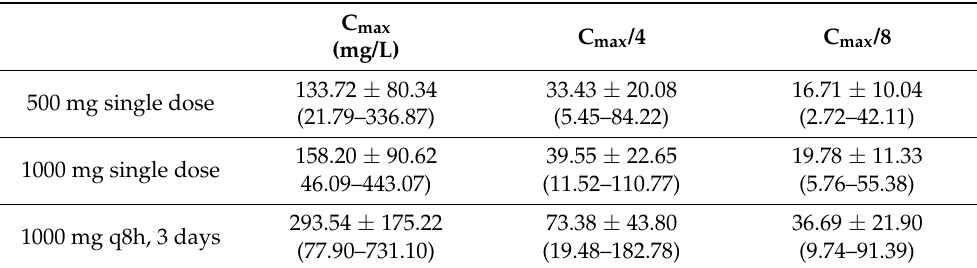
Table 3. C max and C max /MIC ratio of urine fosfomycin in the volunteers receiving fosfomycin at different dose levels. Values expressed as mean ± standard deviation. In parenthesis, maximum and minimum values.